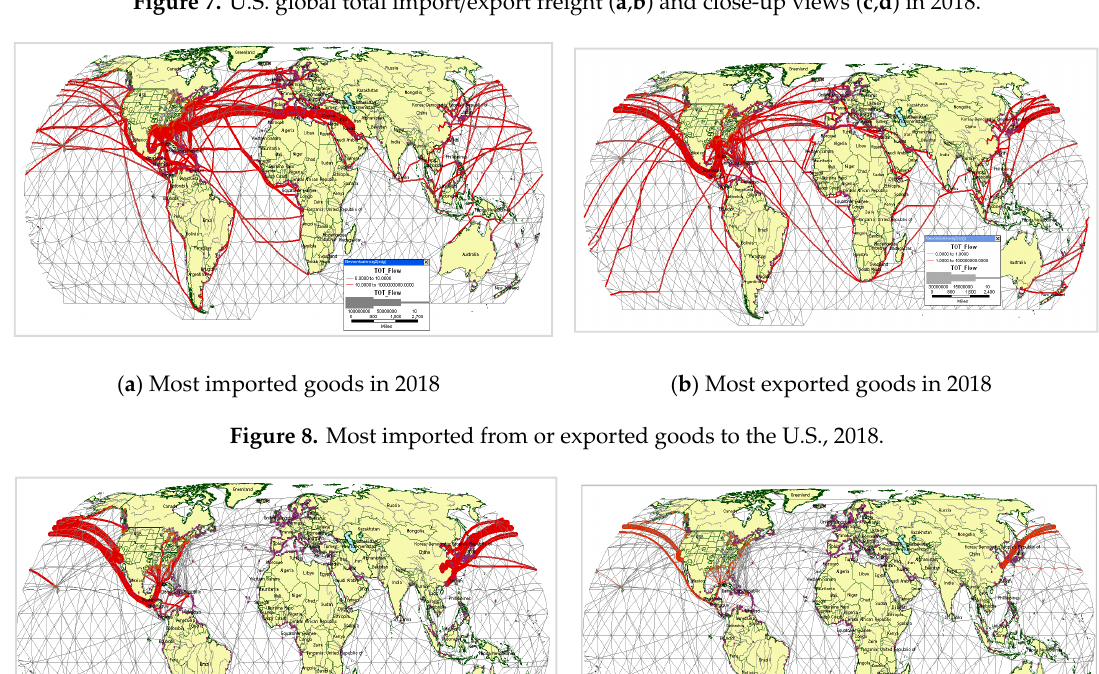
87.00% Mega regions are characterized by a social, economic, and spatial expansion of population, commerce, transportation, and resources across a geographical space; and a total population count exceeding 10 million residents whom are spread among several urban areas in close proximity [39]. With increasing urbanization and globalization, mega regions play important roles in international trade. Figure 10 summarizes some key characteristics of three major mega regions in China. China has been one of the top three trade partners with the U.S. The three mega regions together contributed over 87% of China’s exports to the USA in 2009, as shown in Table 5. This percentage has been rising during the period of 2008–2018.